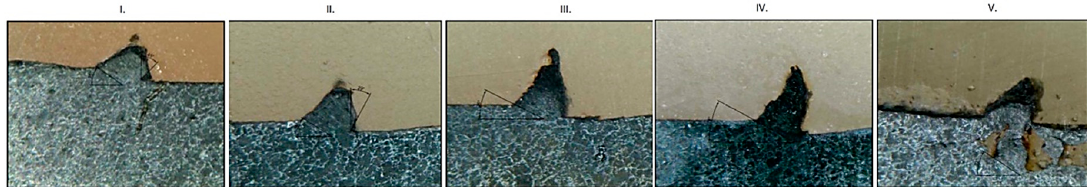
Figure 11. Successive chip roots (magnified 200×) of carbon steel EN C45 at oblique cutting with the